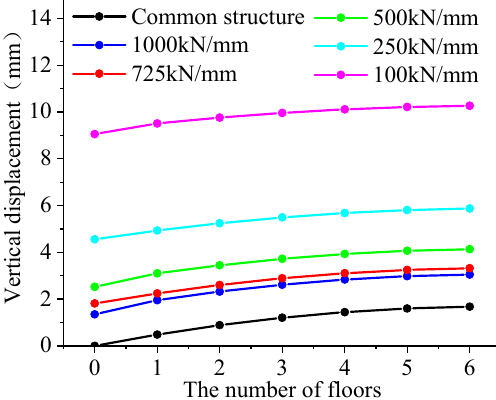
Figure 17. Vertical displacement as the stiffness changes.